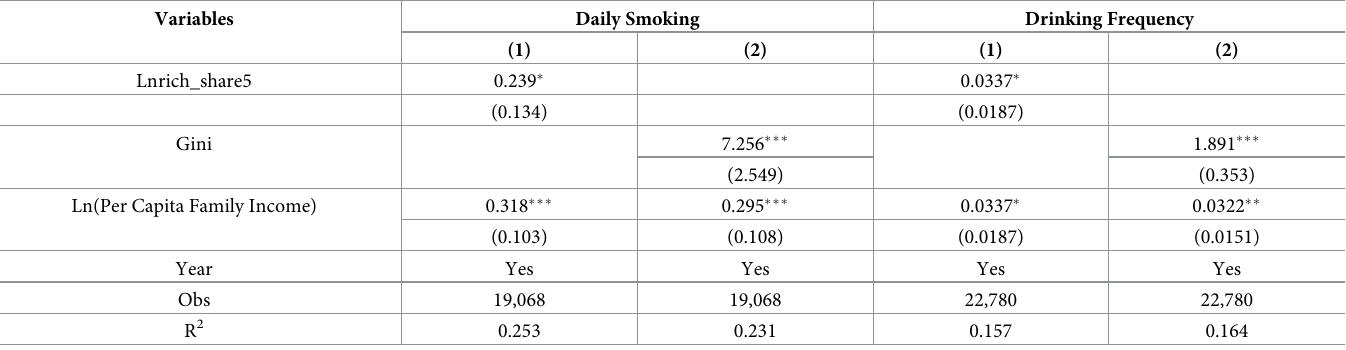
Table 10. Income inequality and health hazardous